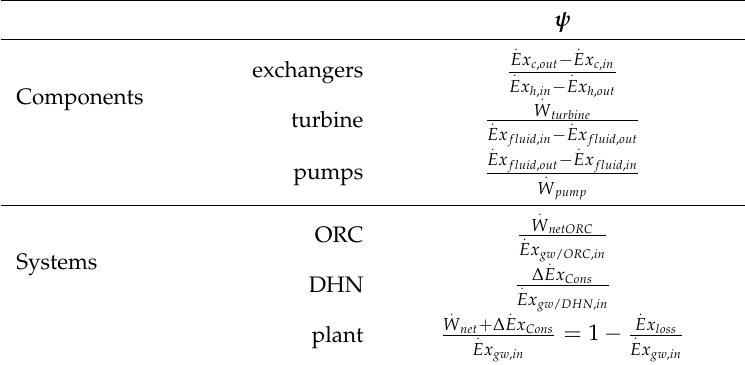
Table 3. Expression of exergy efficiency ( ψ ) for each component and